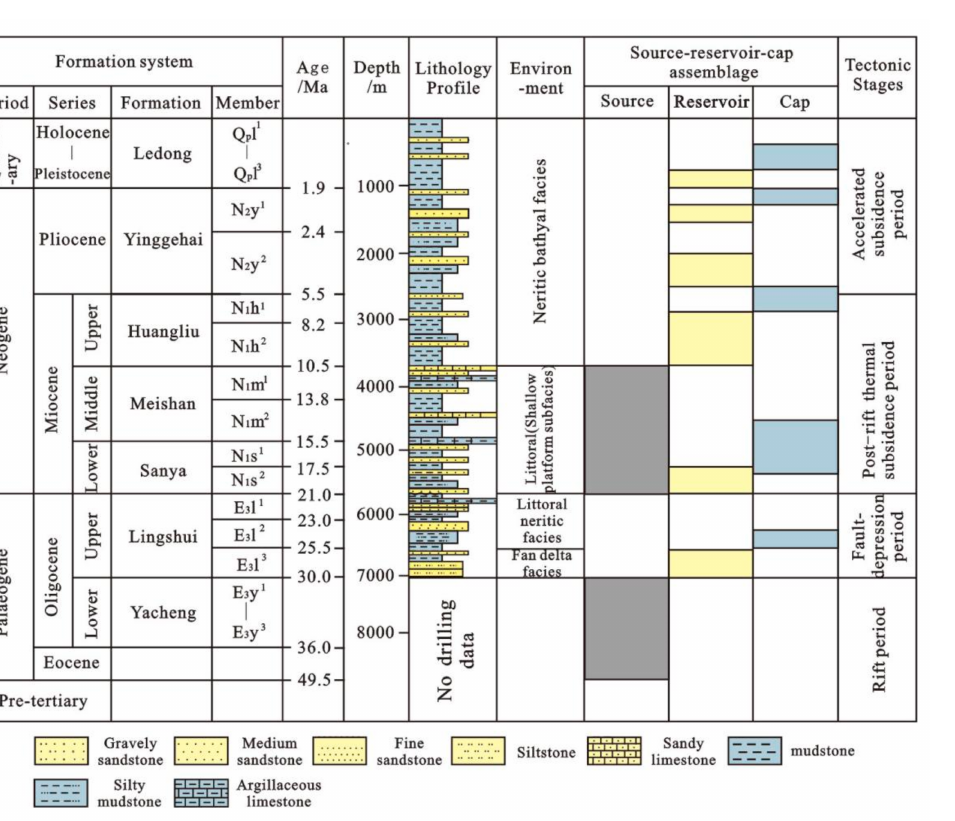
Figure 2. Comprehensive strata log diagram of the Yinggehai Basin with the source-reservoir-cap assemblage and main tectonic event.